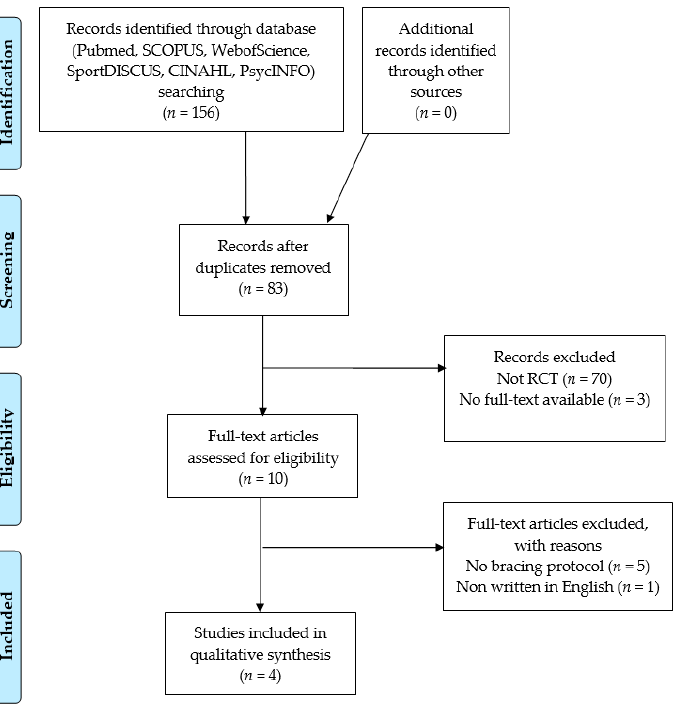
Figure 1. Preferred reporting items for systematic reviews and meta-analyses flow diagram for study selection.